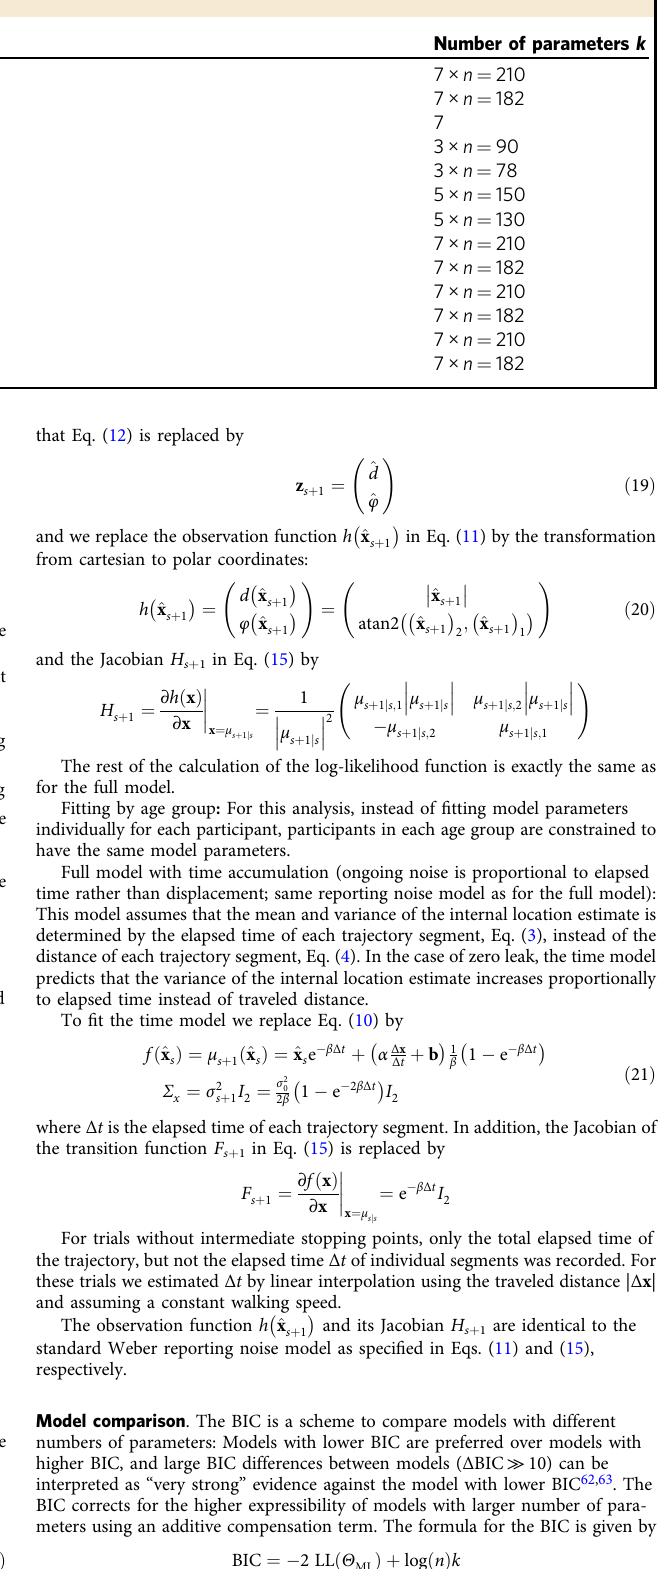
Table 1 Number of parameters for different